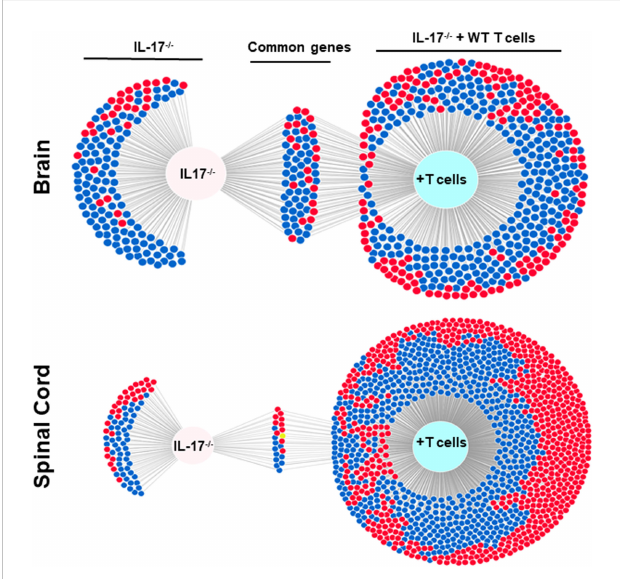
FIGURE 8 Venn diagram of upregulated, downregulated, and common genes in brain and spinal cord of infected mice. Five IL-17A -/- mice with and without T cell transfer from 5 WT mice were infected with 2 X10 5 pfu/ eye of HSV-IL-2 virus and T cells from the brain and spinal cord of infected mice on 14 days PI were isolated. Brains and spinal cords from 5 naive mice of the same age were also isolated and used to normalize gene expression in infected mice. The transcriptomes of brain and spinal cord of IL-17A -/- infected mice were compared with the corresponding tissue in mice that received T cells from WT mice. Venn diagram shows the numbers of genes uniquely or commonly detected in brain and spinal cord of infected IL-17A -/- mice with and without T cells transfer. Red dots show upregulated genes, while blue dots show downregulated genes. Data are based on three independent replicates.